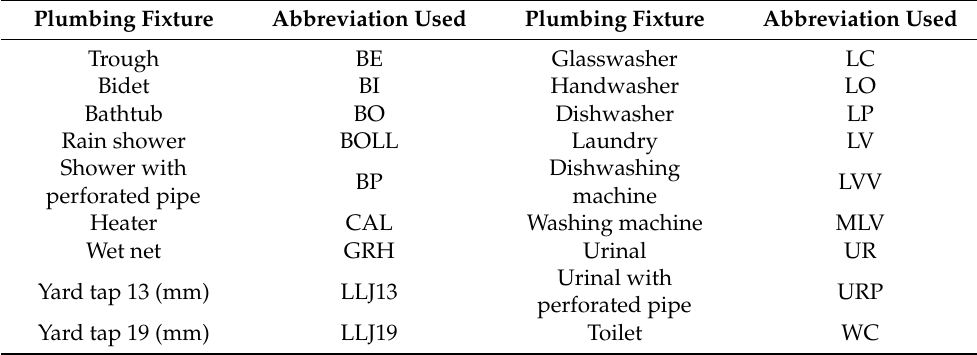
Table 2. Acronyms used for the design of artefacts based on the Chilean RIDAA standard.